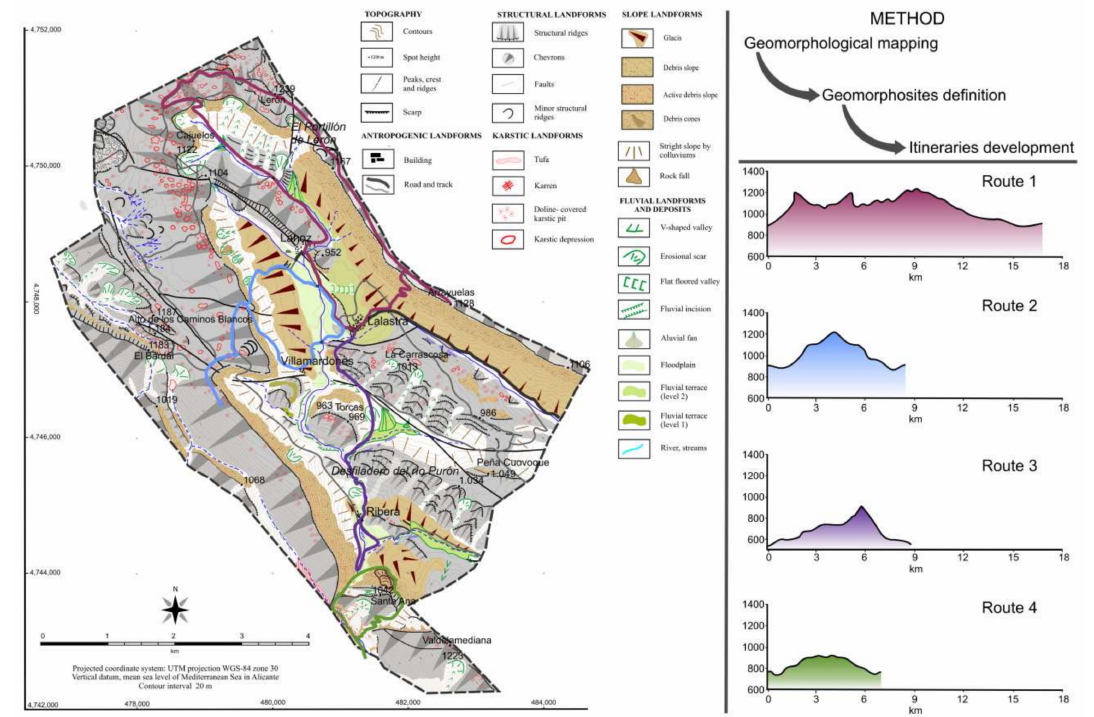
Figure 9. Geotouristic itineraries of Valderejo Natural